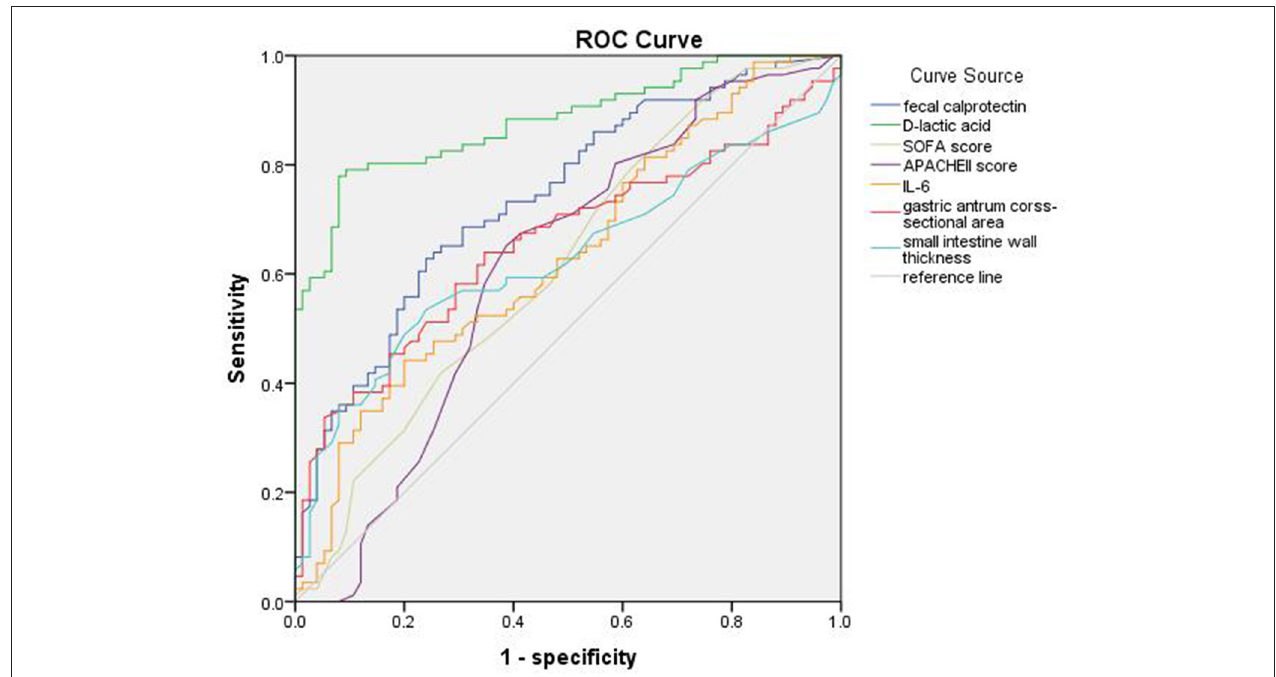
FIGURE 3 | ROC curve of fecal calprotectin, D-lactic acid, SOFA score, APACHEII score, IL-6, gastric antrum cross-sectional area and small intestine wall thickness of sepsis with AGI.